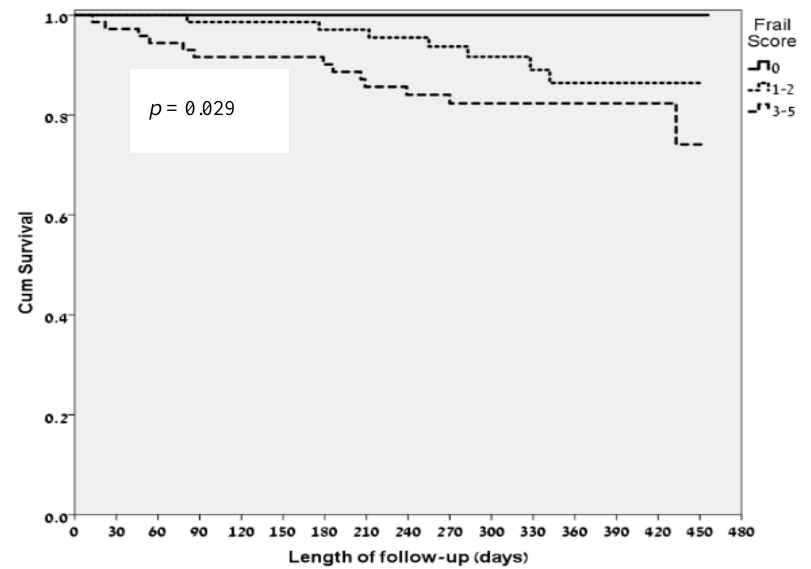
Figure 3. Kaplan-Meier survival curve according to FRAIL Questionnaire.